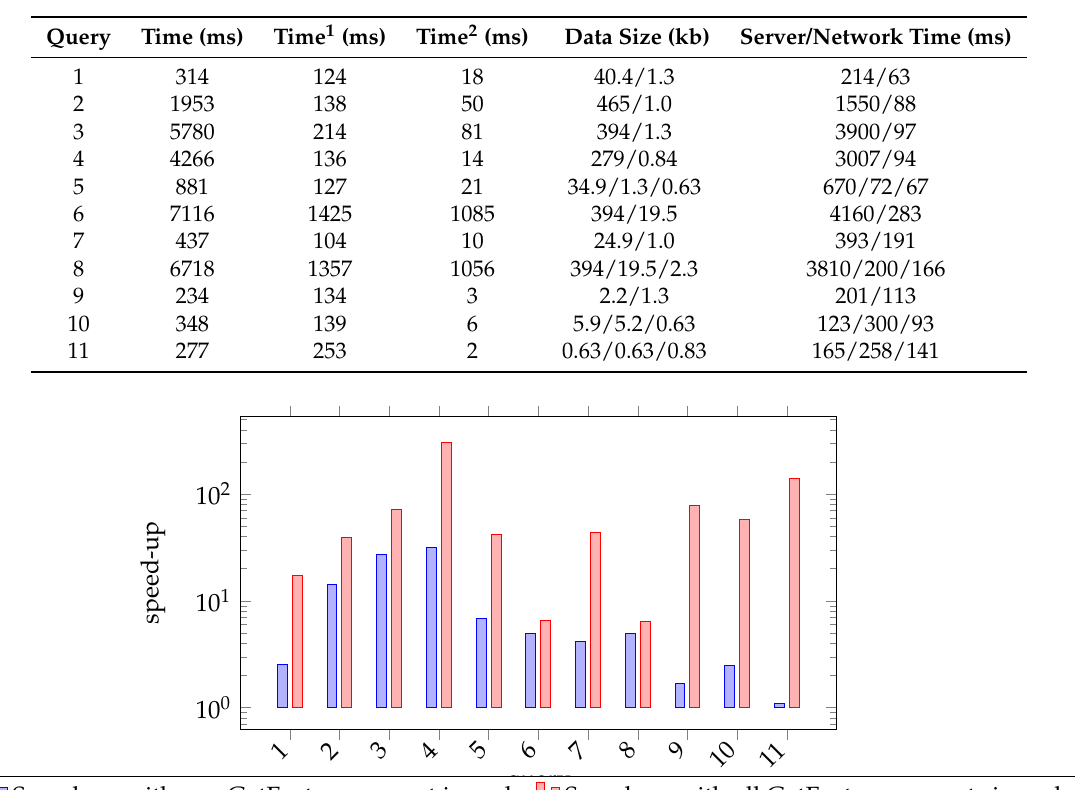
Table 4. Runtime performance of queries, where the columns Time , Time 1 , and Time 2 are query runtime without caching, runtime with one cache hit (of the feature with the most number of instances), and runtime with cache hits of all features, respectively. The runtime includes the time for WFS queries, spatial join, and browser rendering. The last two columns show the size of the data retrieved from each WFS request and the corresponding time of server response and network transmission.